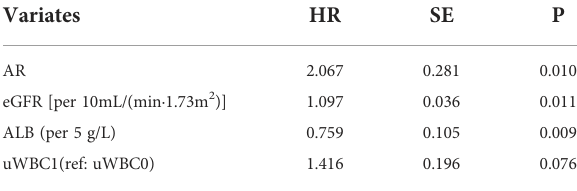
TABLE 3 Results of static Cox regression